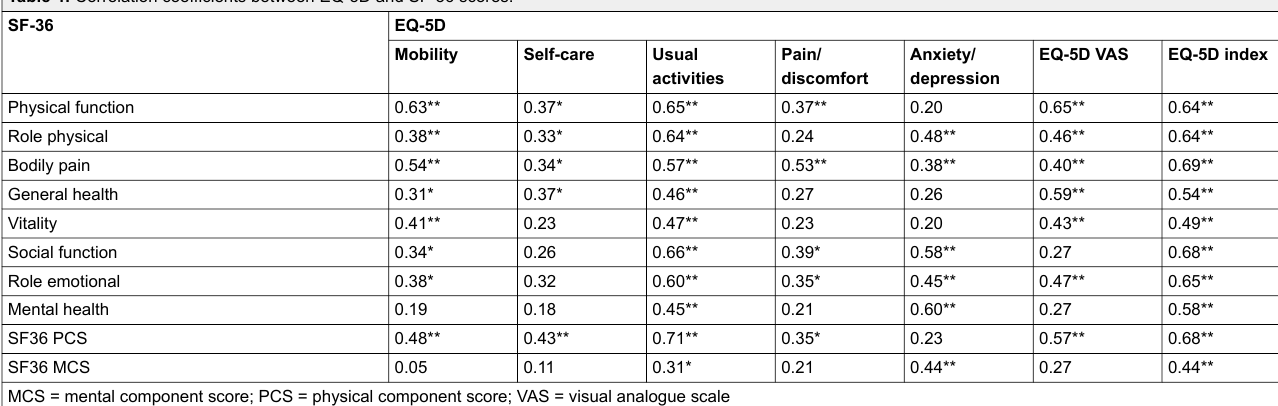
Table 4: Correlation coefficients between EQ-5D and SF-36 scores.